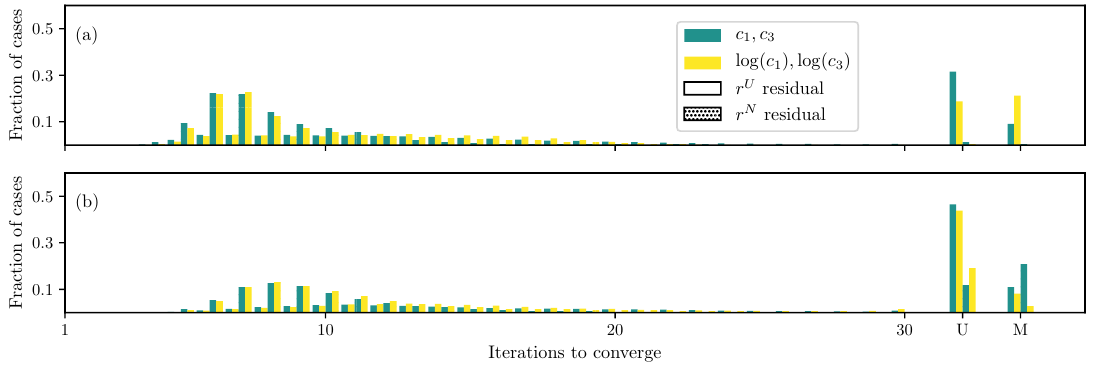
Figure 4. Iterations required using different formulations for the Humphrey model (4) DC case when ( a ) all parameters except the fiber angle θ are unknown and ( b ) all parameters are unknown.